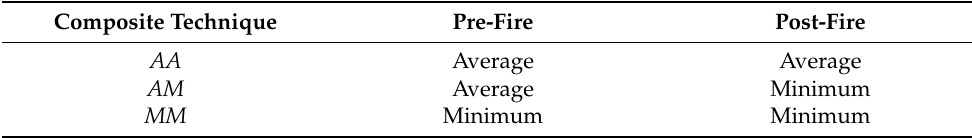
Table 4. Composite techniques analyzed for GEE Sentinel-L2A